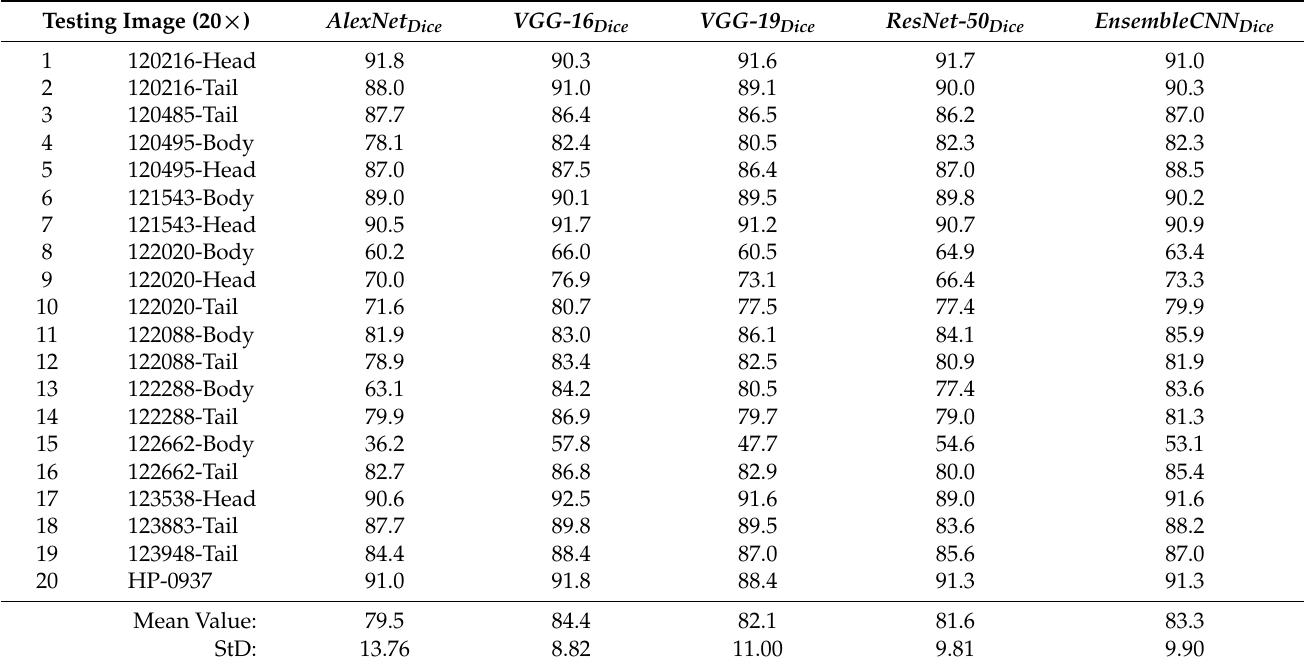
Table 6. Sorensen–Dice fat segmentation